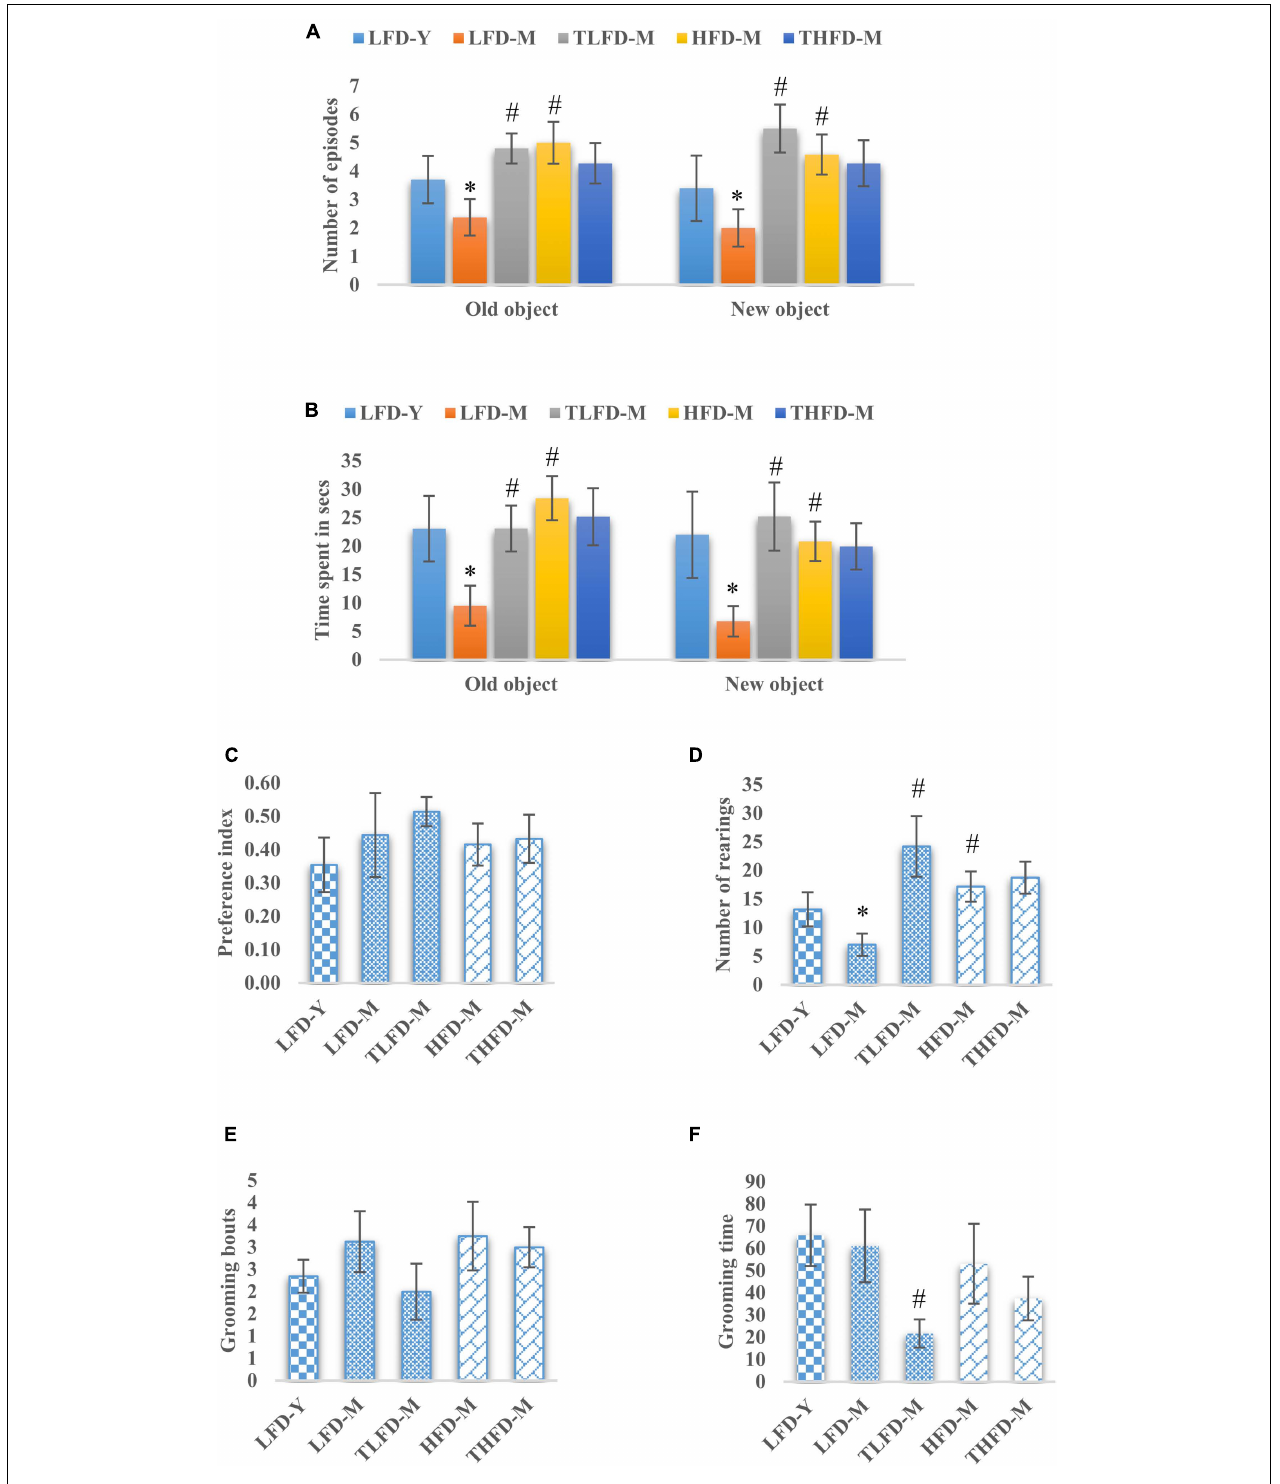
FIGURE 2 | Tinospora cordifolia stem powder (TCP) supplementation improved memory and exploratory behavior in middle-aged acyclic female rats. Histogram representing (A,B) number of episodes and time spent of the animals, (C) preference index of the animals for a new object, (D) number of rearing episodes on exploring an object, and (E,F) number of grooming bouts and time spent by middle-aged acyclic female rats in grooming activity. Values are presented as mean ± SEM. ∗ p ≤ 0.05 LFD-Y vs. LFD-M; # p ≤ 0.05 LFD-M vs. HFD-M and TLFD-M.